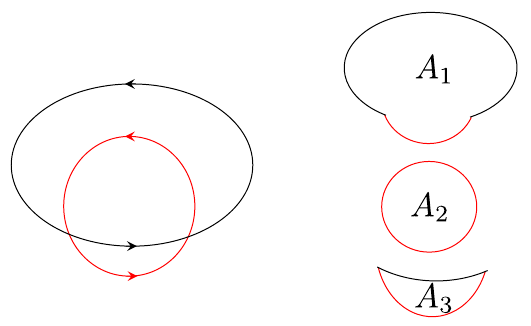
Figure 11 . The two intersection loop and the de(cid:12)nition of the areas. A 1 is the area of the whole regions inside the loop while A 2 is the area inside the red circle. A 3 is the area inside a small subregion in the bottom bounded by the red and black curves.